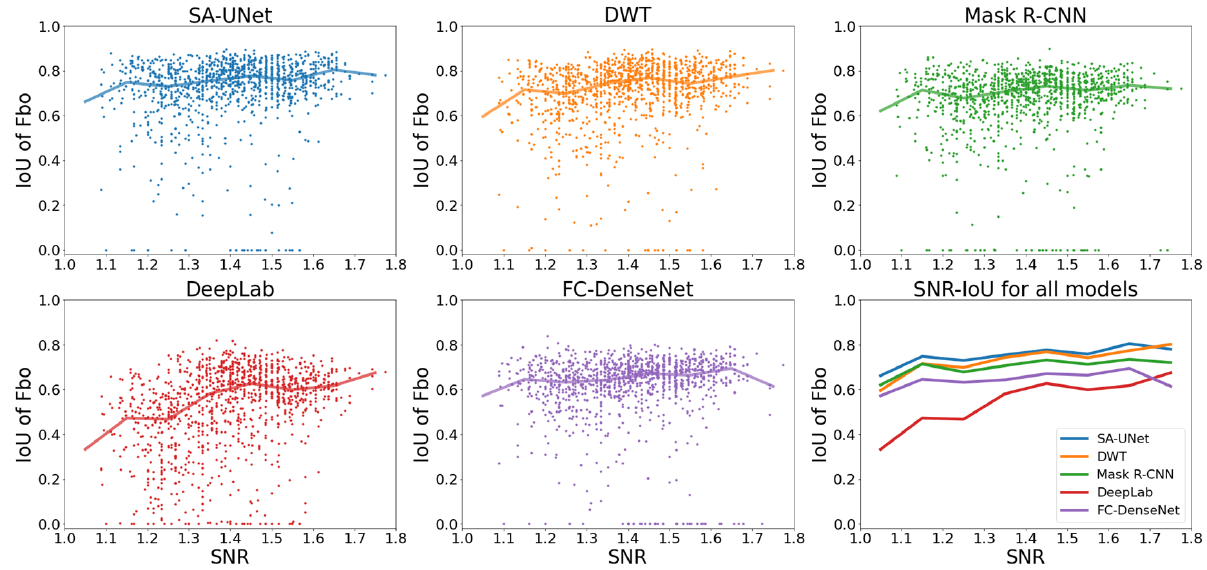
Figure 6. Comparison of IoU of Fbo vs. SNR for all models (different colors represent different mod- els: blue: SA-UNet, orange: DWT, green: Mask R-CNN, red: DeepLab, purple: FC-DenseNet). models: blue: SA-UNet, orange: DWT, green: Mask R-CNN, red: DeepLab, purple: